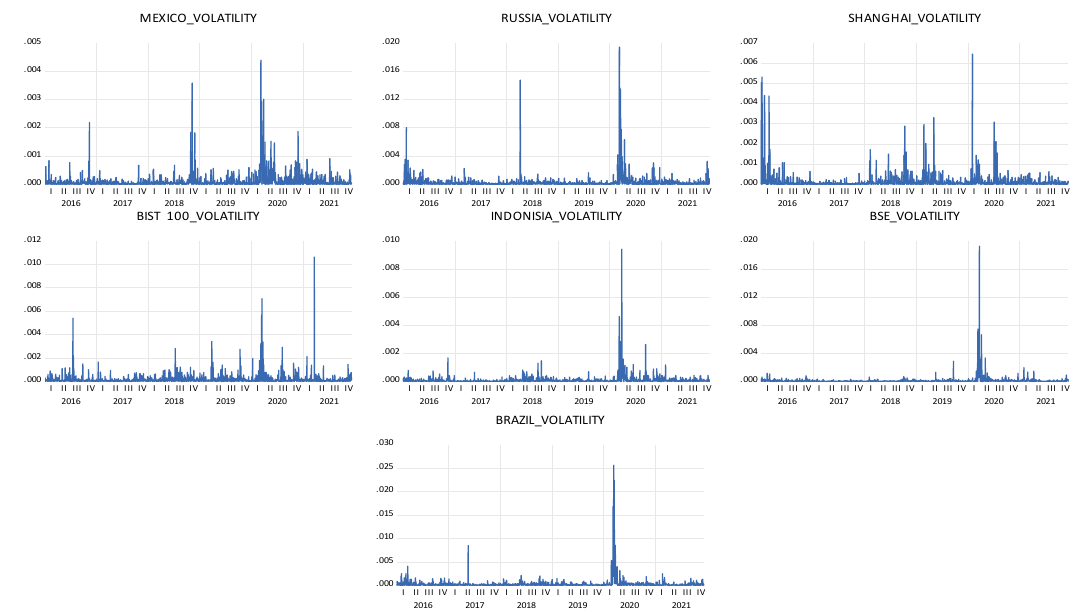
Figure 6. E7 volatility clustering (sources Data Stream). The outcome of the FIGARCH (1, 1) shows a lack of a long memory process. As RTS INDEX, BOLSA, and SHANGHAI show negative volatility spikes α = ( − 0.094854), ( − 0.066332), ( − 0.023439), and BOVESPA shows negative volatility spikes and persistence α = ( − 0.582253) and β = ( − 0.505079). On the other hand, BIST 100, IDEX, BSE 100 D = 0.196344, 0.310872, 0.48343 has long memory volatility as the d is positive and <0.5 (Härdle and Mungo 2007).